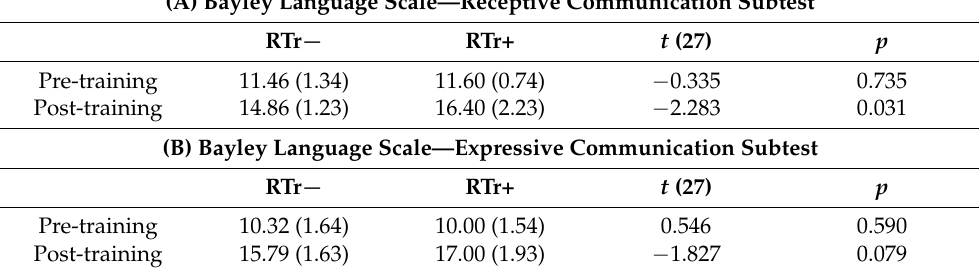
Table 2. Mean (standard deviation) of the Bayley Language scale raw scores and Group comparisons at pre- and post-training.